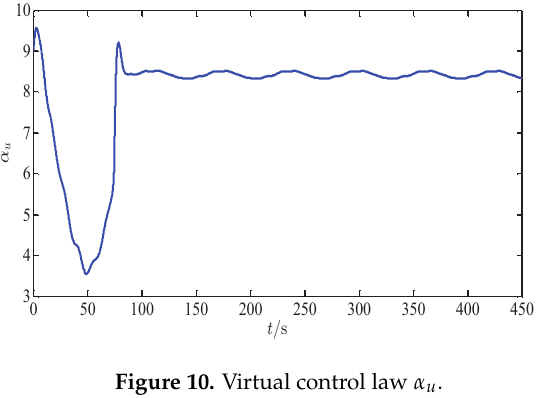
Figure 9. Approximation error results of neural network.